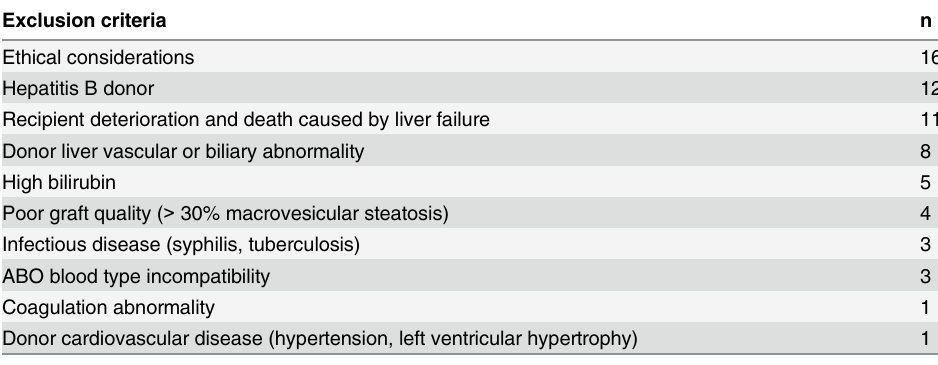
Table 1. Exclusion criteria for the